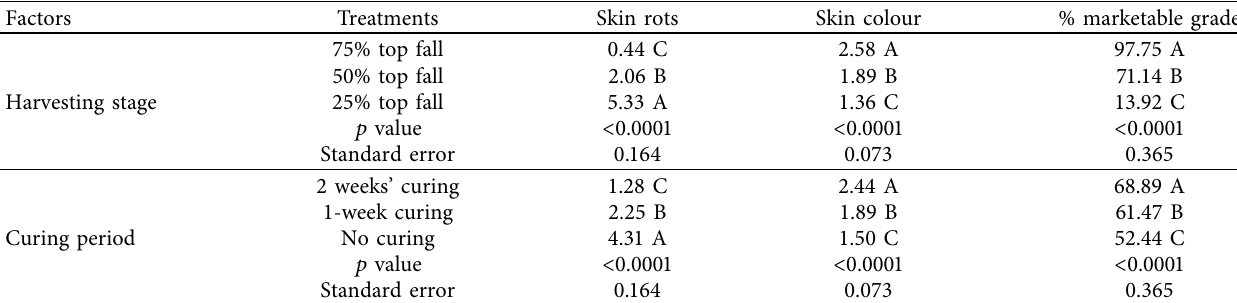
Table 4: Visual quality of bulb onions subjected to harvest and postharvest